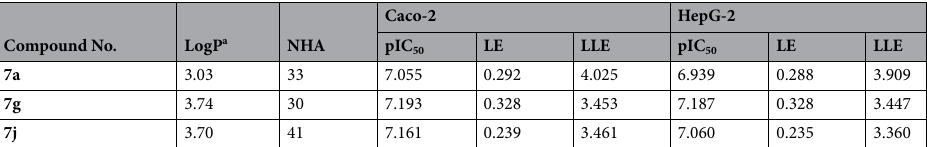
Table 5. Ligand efficiency (LE) and lipophilic ligand efficiency (LLE) metrics of selected Passerini adducts. a LogP: logarithm of compound’s partition coefficient between n -octanol–water. b NHA = non-hydrogen atom. c pIC 50 : half-maximal inhibitory concentration (in term of molar concentration). pIC 50 = -log (IC 50 ). efficiency. LE = 1.37 (pIC 50 )/NHA. The lower acceptable limit of LE is 0.3 45 . d LLE: lipophilic ligand efficiency. LLE = pIC 50 –cLog P. LLE values ≥ 3 are acceptable for lead compound, while values ≥ 5 are recommended for drug-like candidate 45,46 .